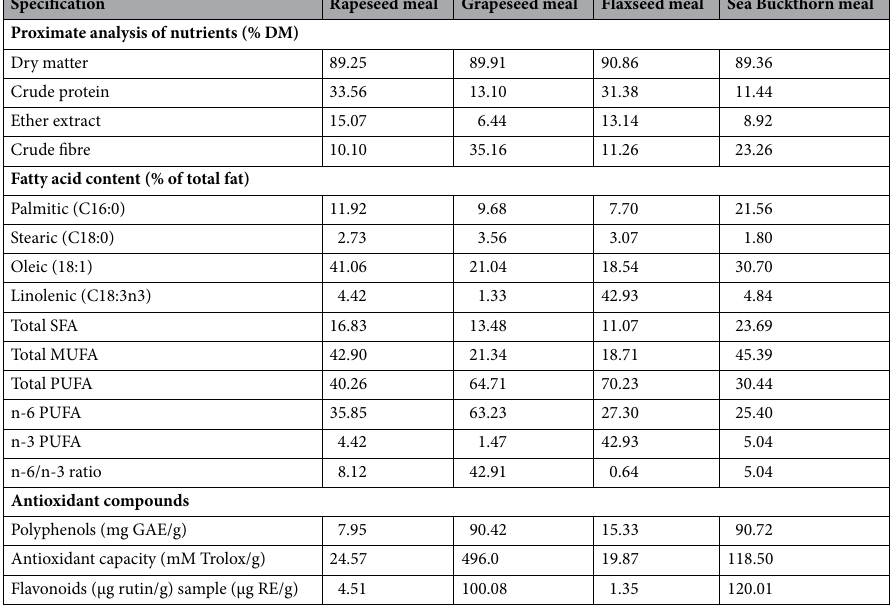
Table 5. Proximate chemical composition and nutrient profile of dietary by-products. PUFA polyunsaturated fatty acids, DM dry